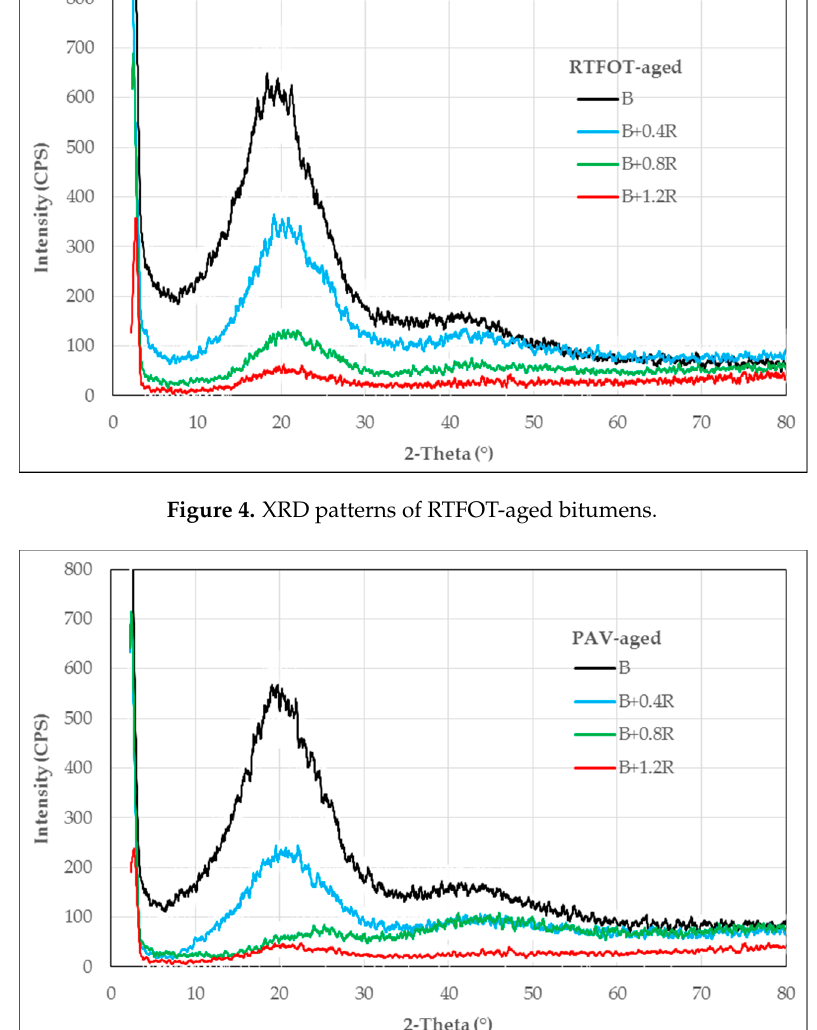
Figure 5. XRD patterns of PAV-aged bitumens.